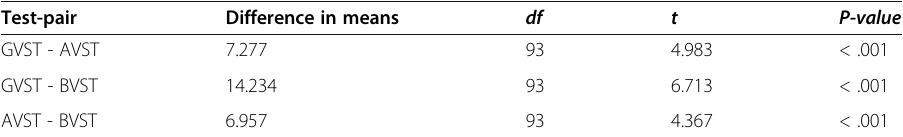
Table 6 t -test results in inter-test mean scores Test-pair